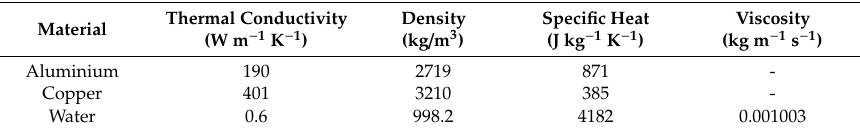
Figure 5. Principal tube dimensions.